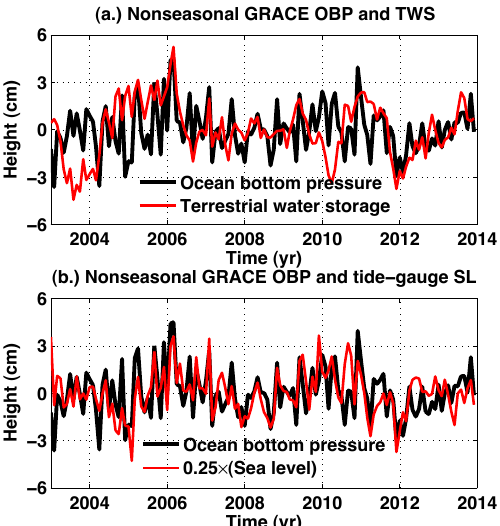
Figure 2. (a) Nonseasonal GRACE Release-05 2003–2013 ocean bottom pressure averaged over the Canadian inland seas (black) and terrestrial water storage averaged over the Hudson Bay drainage basin (red). (b) Nonseasonal GRACE Release-05 2003–2013 ocean bottom pressure averaged over the Canadian inland seas (black) and Churchill tide-gauge sea level (red). Sea level time series is multi- plied by 0.25 to fit within axis limits. All quantities shown in equiv- alent water thickness with units of